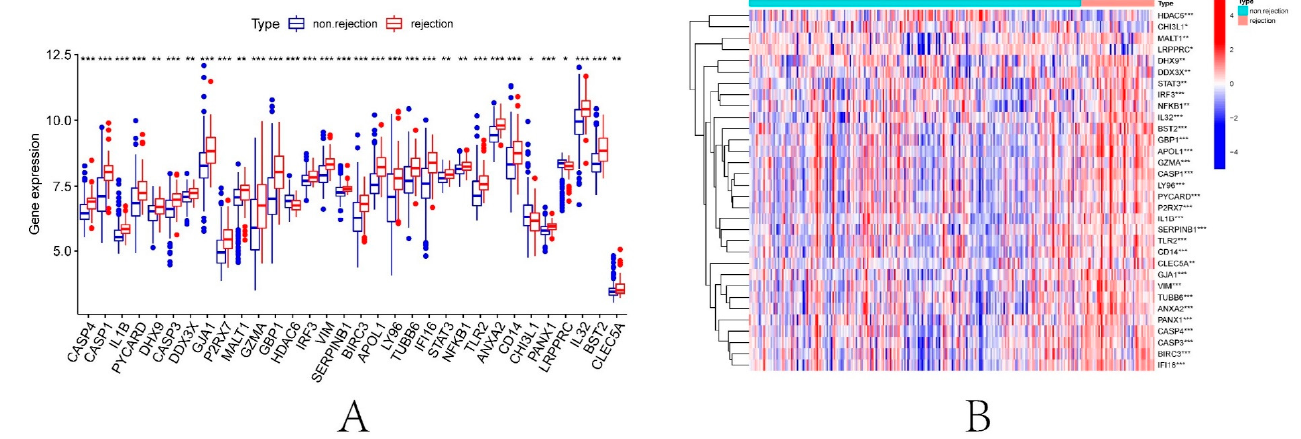
Figure 6. Identification of DEPRGs in kidney transplantation. ( A ) Boxplot of 33 DEPRGs expression. ( B ) Expression heatmap of 33 DEPRGs. * p < 0.05, ** p < 0.01, *** p < 0.001.